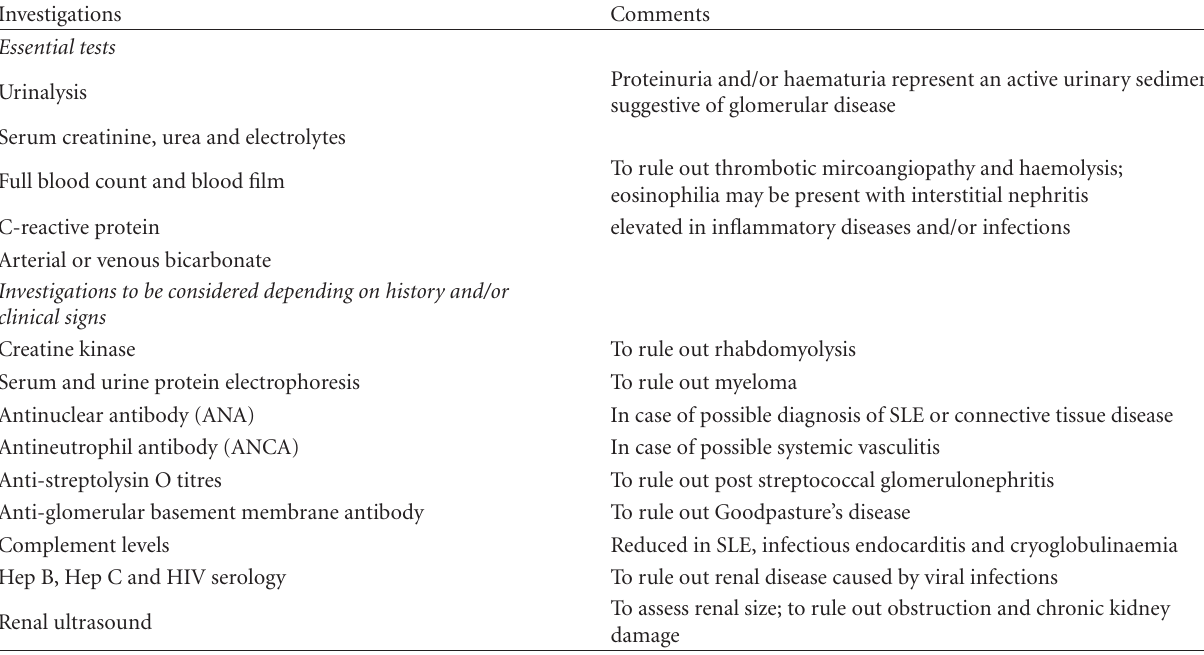
Table 2: Diagnostic work-up of patients with